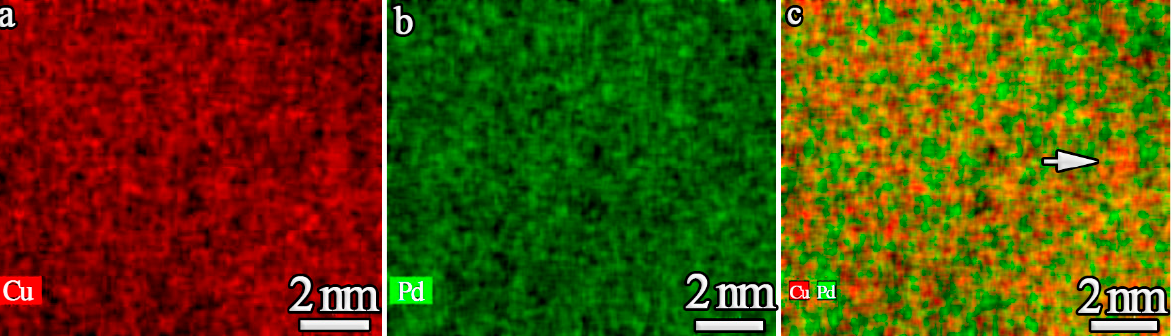
Figure 4. Distribution of components (EDXS elementl maps) in the Cu-Pd36 sample: ( а ) Cu, ( b ) Pd, ( c ) Cu + Pd. One of Cu cluster is indicated by an arrow.